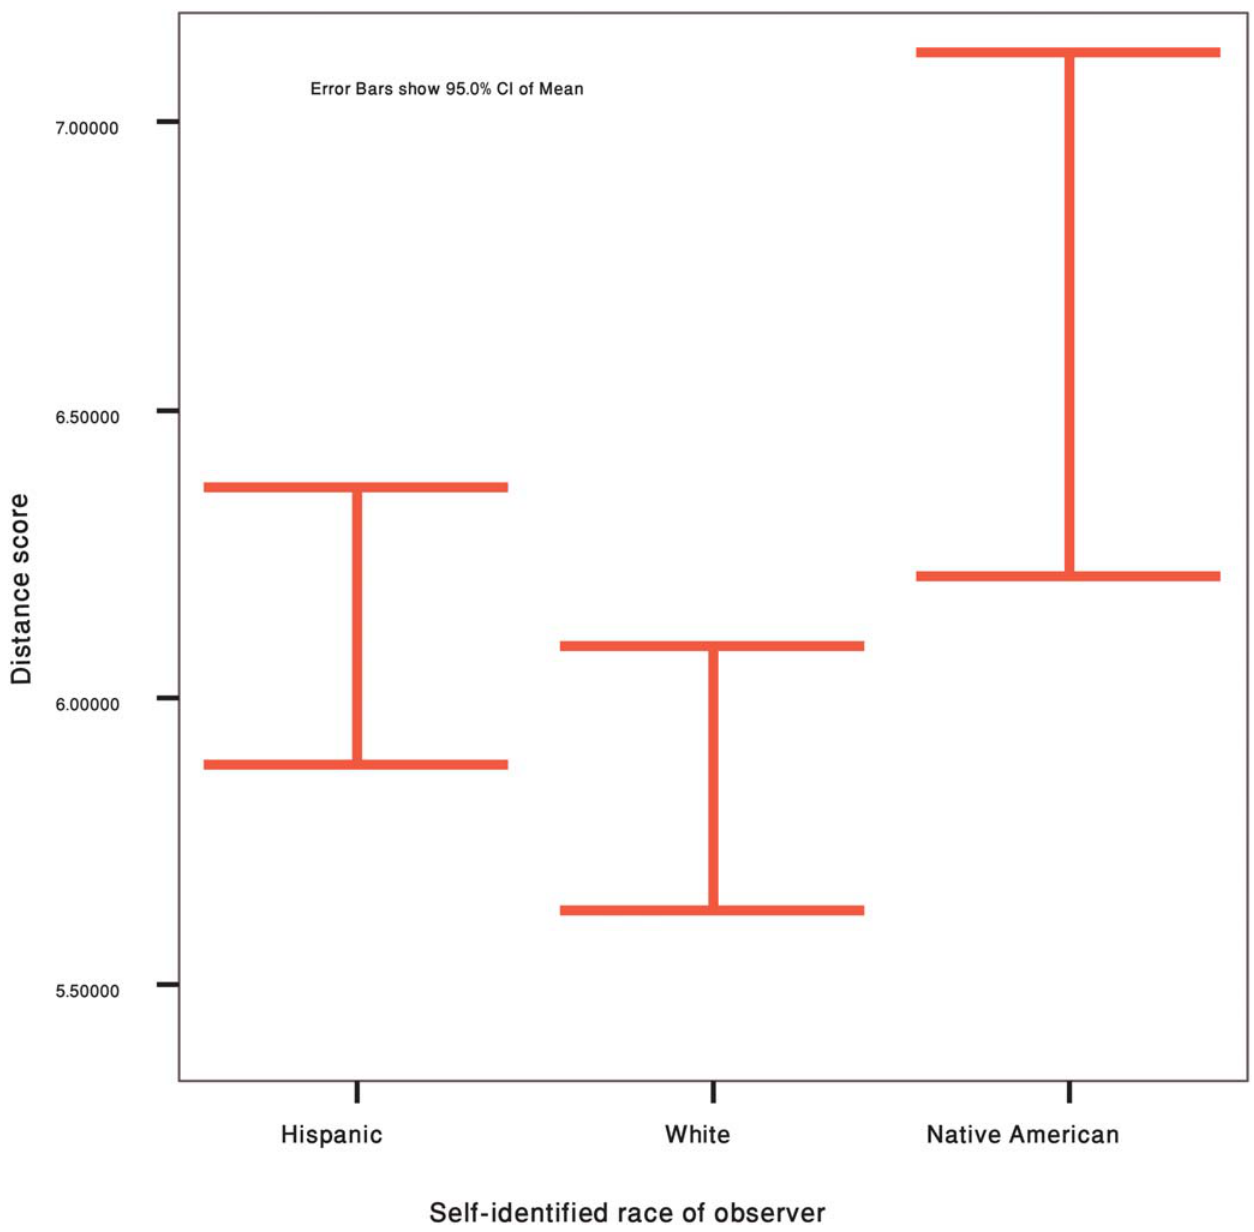
Figure 2. Average Euclidean distance score by race/ethnicity. Error bars show 95% CI of Mean.